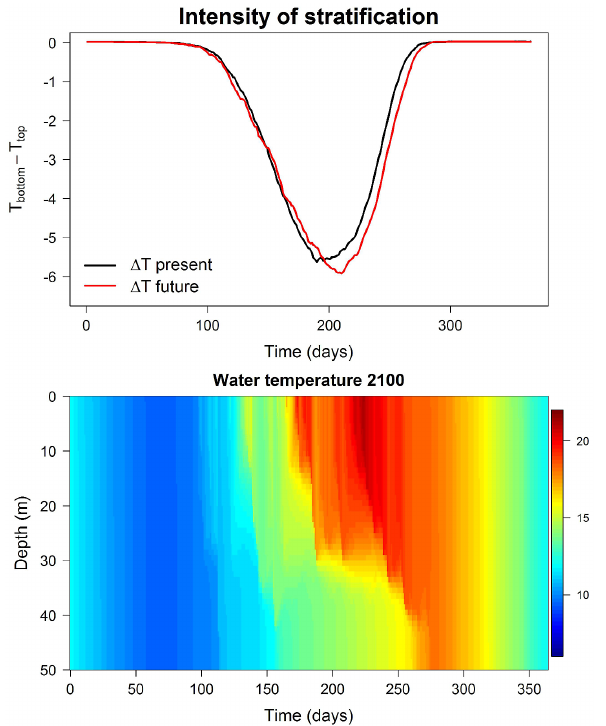
Fig. 8. Intensity of the stratification calculated as the difference be- tween the water temperature in the bottom and the top layer for present (2007) and future (2100) water column (top panel). The bot- tom panel shows the water temperature for the year 2100 as calcu- lated by the physical model.